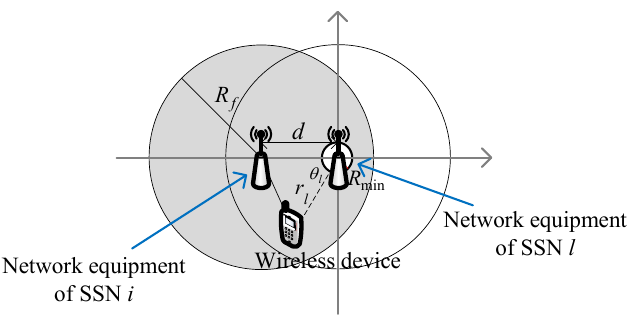
Figure A2. Two-SSN scenario with d ≤ R − R min